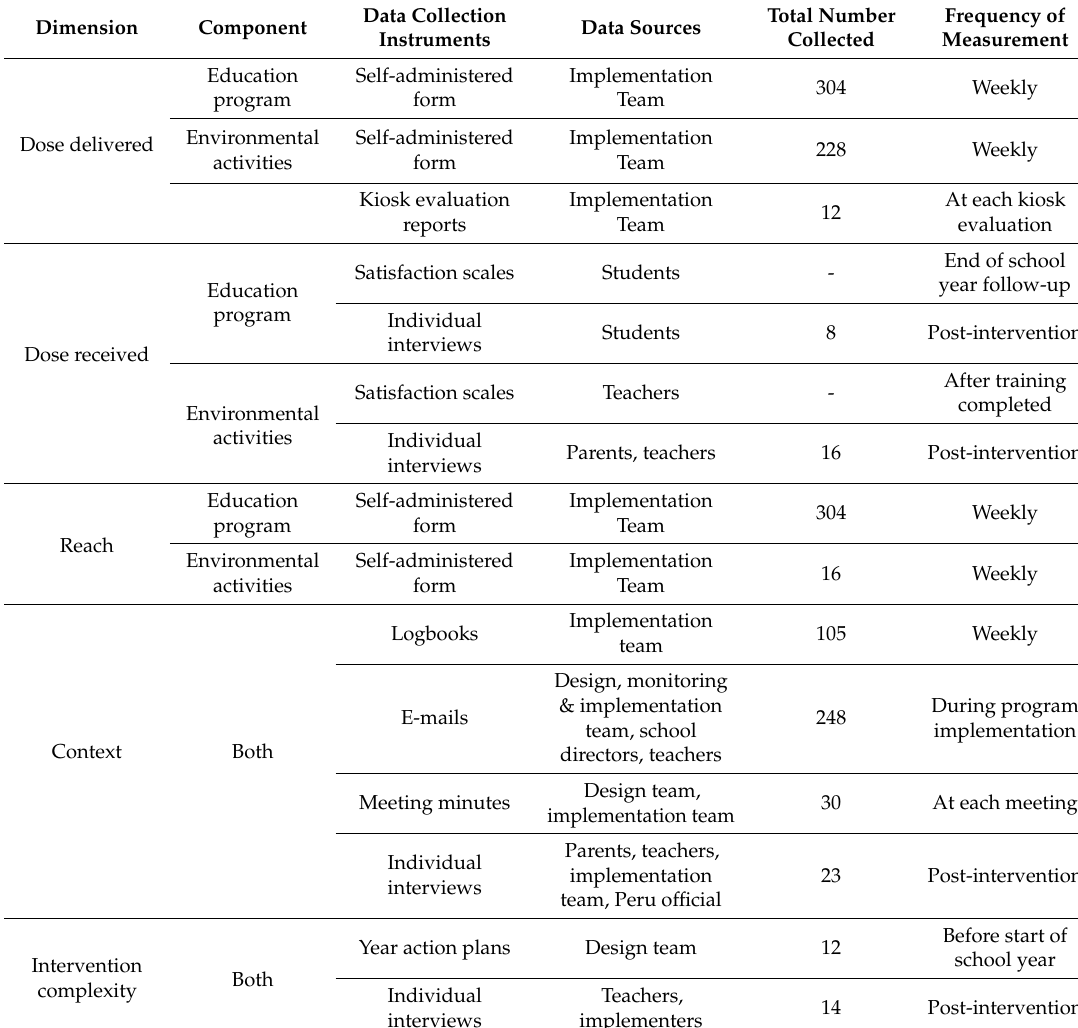
Table 3. Data collection methods and data sources for education and environmental activities of the HPS Obesity Prevention